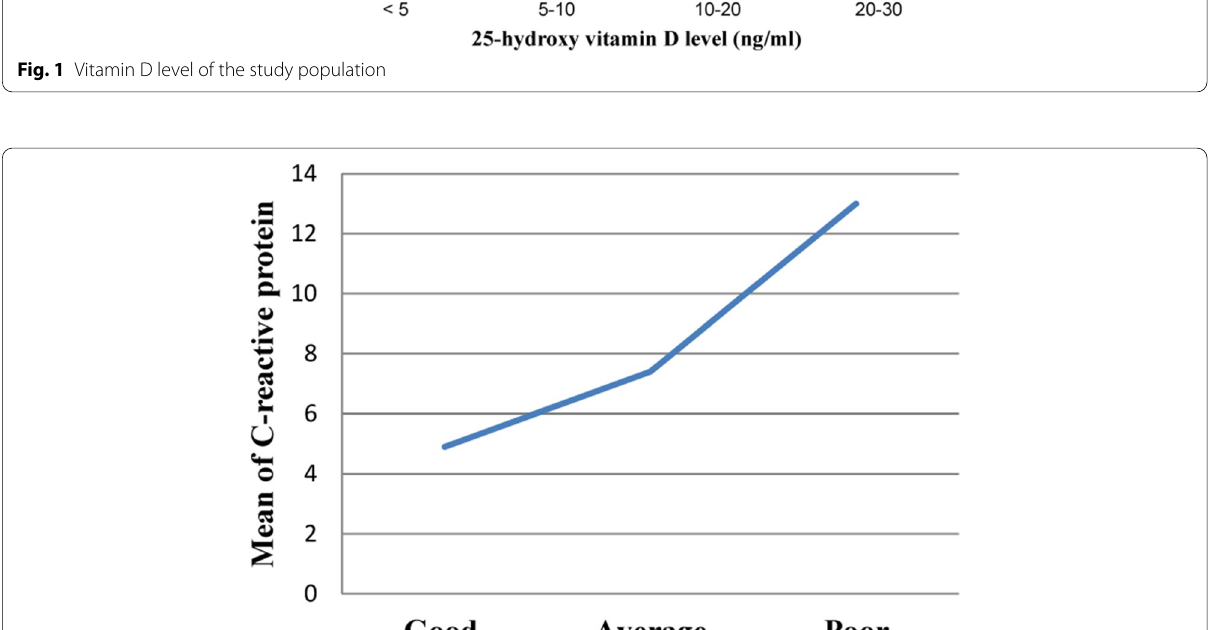
Fig. 2 Mean of CRP for the three categories of marital relationship